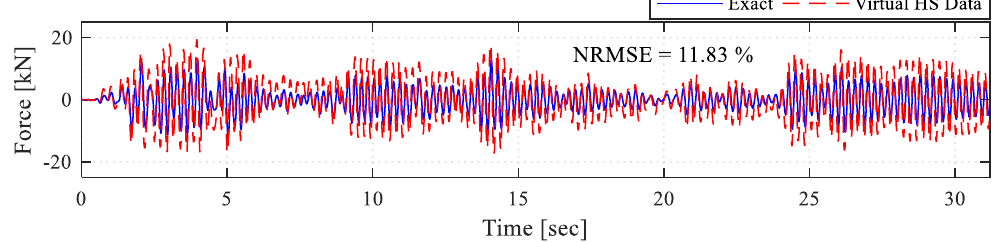
Figure 18. Brace force calculated from Model 1b virtual HS compared to the exact analytical solution.